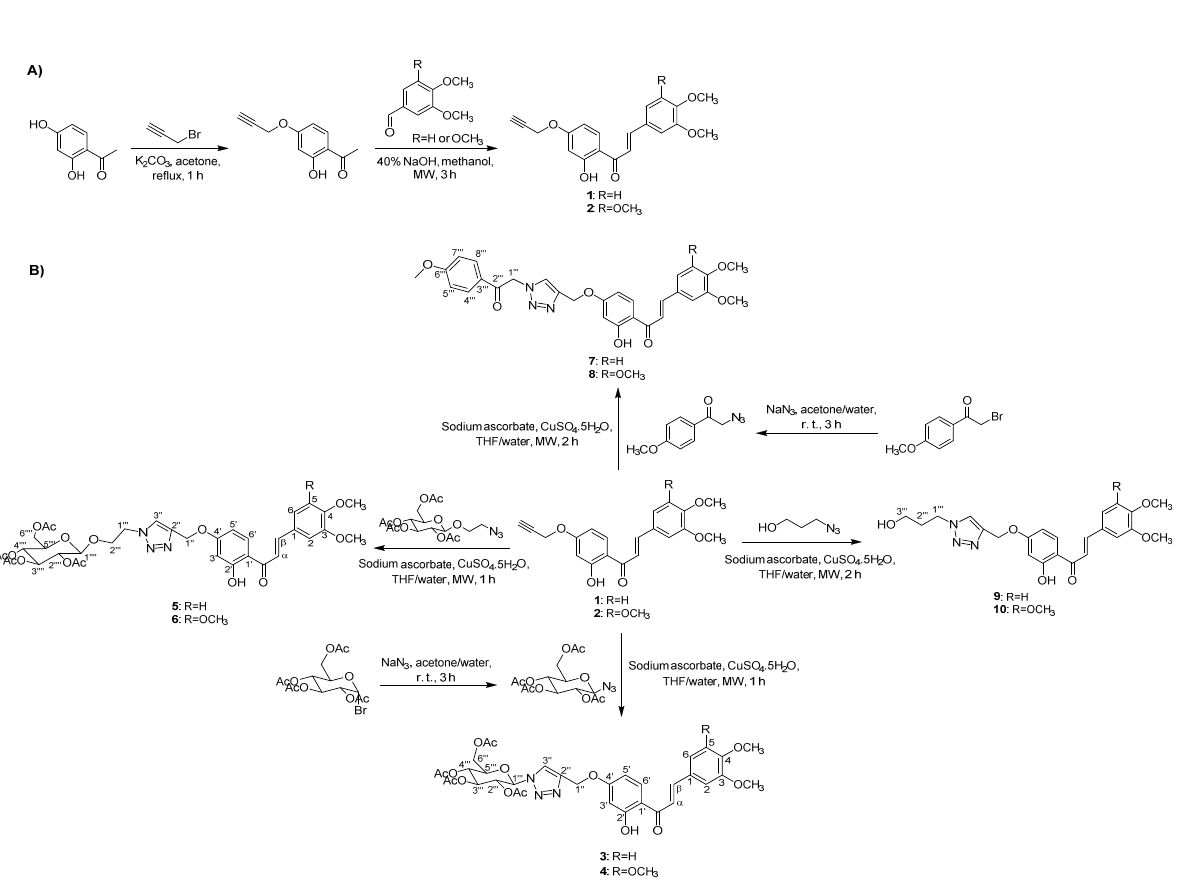
Figure 1. ( A ) Synthesis of intermediate chalcones 1 – 2 . ( B ) Synthesis of chalcone-1,2,3-triazole derivatives 3 – 10 by CuAAC reaction.